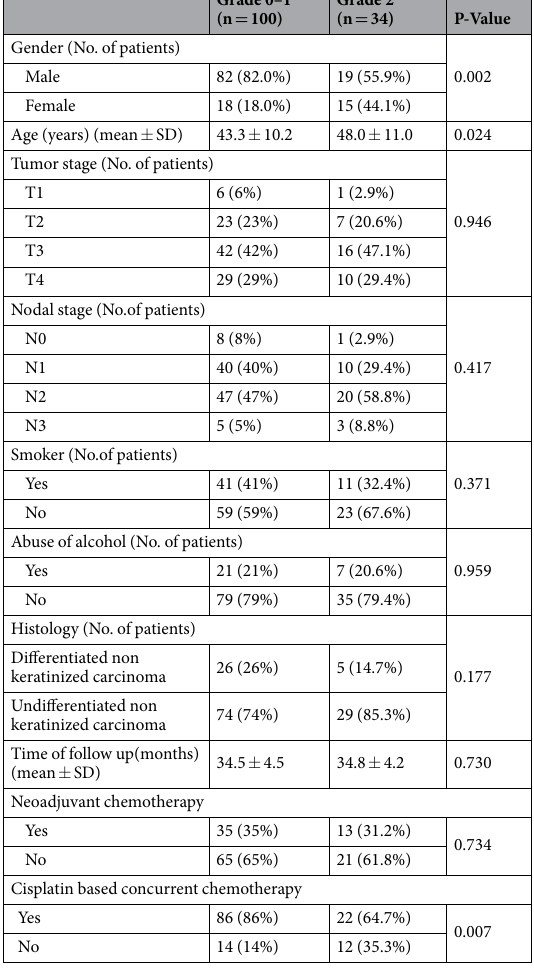
Table 2. The relationship between the patients’ clinical characteristics and the RTOG/EORTC degree of late